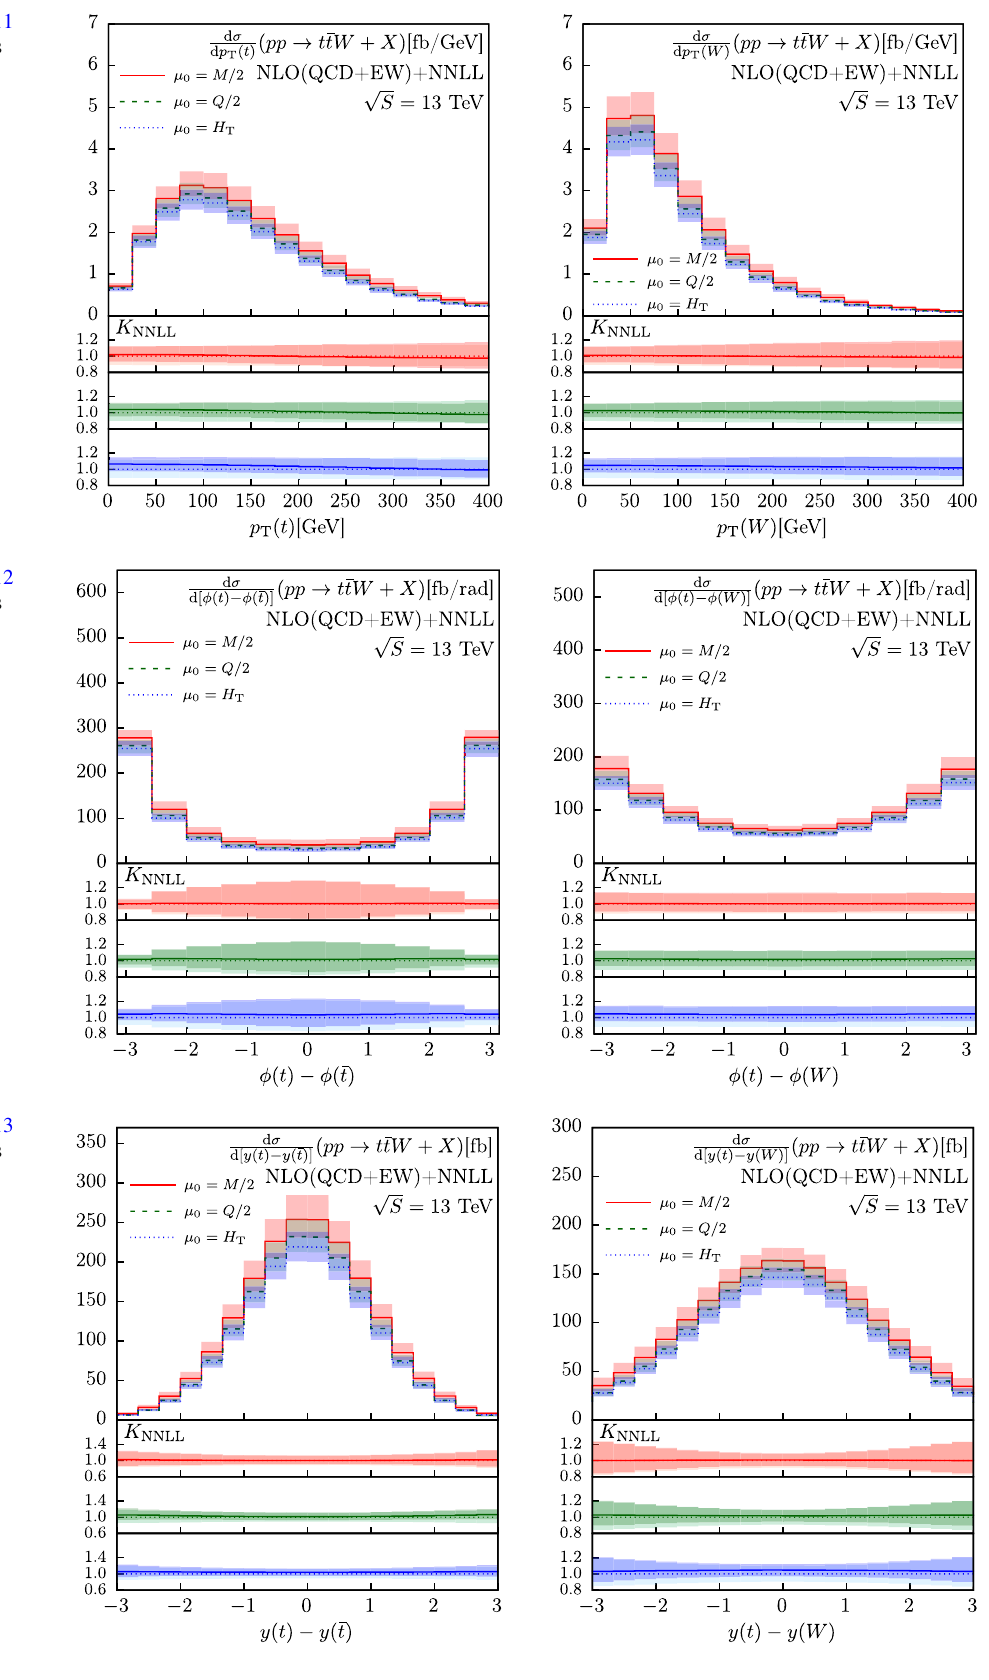
Fig. 19 The same as in Fig. 11 but for the pp → t ¯ tW process